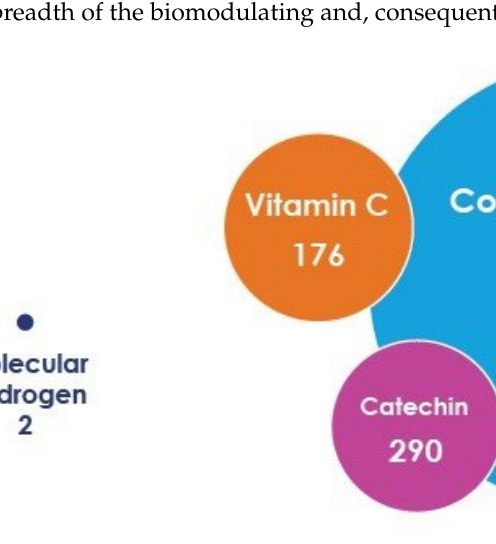
Figure 1. Relative size of molecular hydrogen and some antioxidants based on differences in their molec- ular weights, not their actual effective diameter size (e.g., kinetic diameter or Stokes–Einstein radius). The body of knowledge in the field of H 2 biomedicine is being actively updated, including about 100 randomized controlled trials and more than 2000 articles that have been published by the end of 2022 (Figure 2). Various aspects of the issue are considered in detail, but the focus of research is largely shifted towards the cardiac [11,13], neurological [14,15], and radioprotective effects [16,17] of hydrogen. Several studies assessed the possibility and expediency of using hydrogen in oncological diseases [18–20]. On the other hand, cellular effects, which are fundamentally significant for regenerative medicine, are revealed only indirectly. In this regard, the purpose of this review is to systematize ideas about the nature, features, and mechanisms of the influence of H 2 on cells, specifically stem